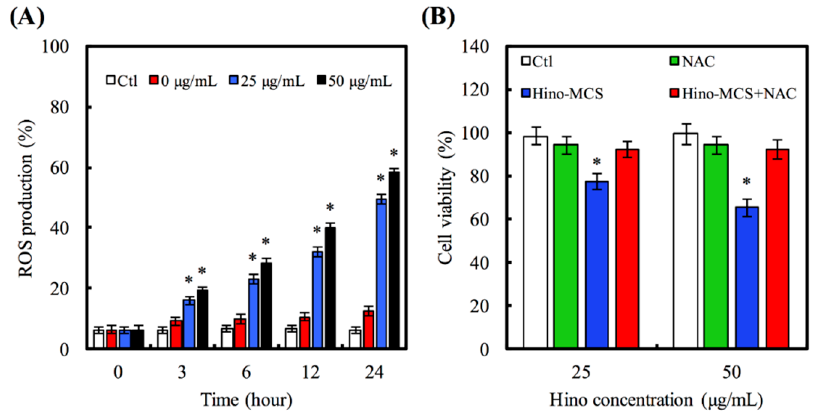
Figure 7. ( A ) A549 cells in response to 25 and 50 µ g/mL Hino-MCS nanoparticles for various time points and the ROS production. Star indicates a significant difference ( p < 0.05) compared to 0 µ g/mL; ( B ) For cell viability, A549 cells were exposed to 25 and 50 µ g/mL Hino-MCS nanoparticles for 48 h before pretreated with or without NAC, respectively. Star indicates a significant difference ( p < 0.05) compared to cell with pretreatment inhibitor.